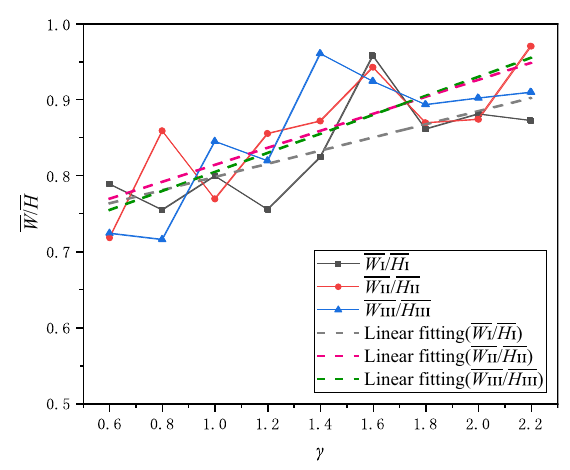
Fig. 14 Average width-to-height ratio of drawing bodies in different